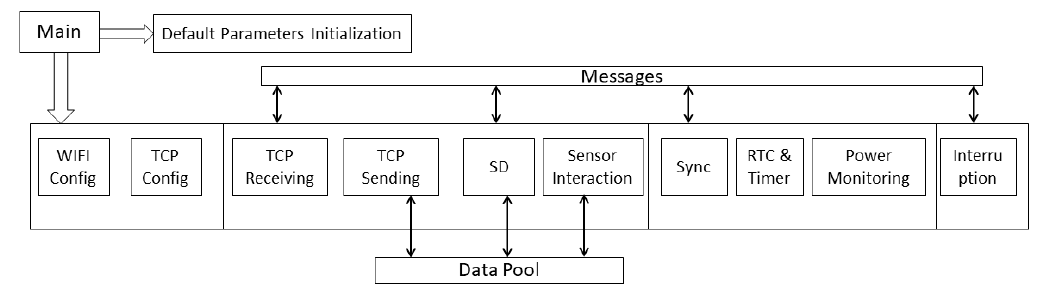
Figure 4. Diagram of the firmware in the CC3220.